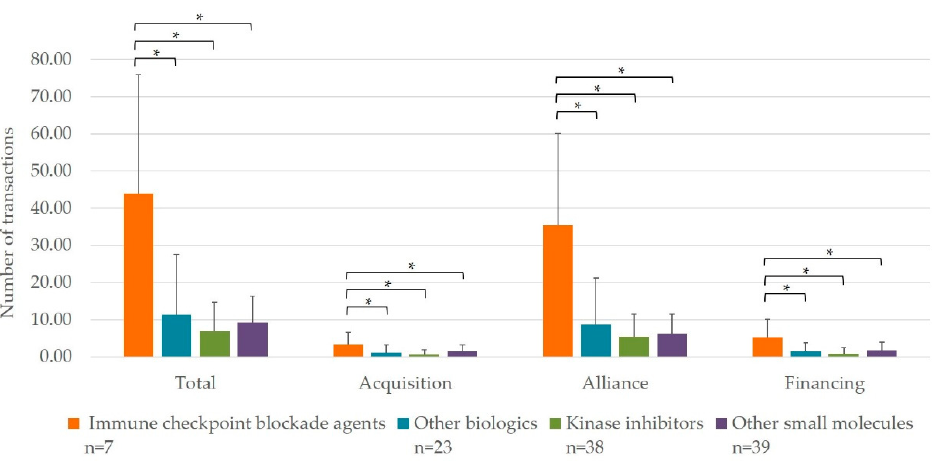
Figure 1. Multiple comparisons of the number of interorganizational transactions by the pairwise comparison procedure among immune checkpoint blockade agents, other biologics, kinase inhibitors and other small molecules. n = 77 (small molecules) and 30 (biologics). * p < 0.05.